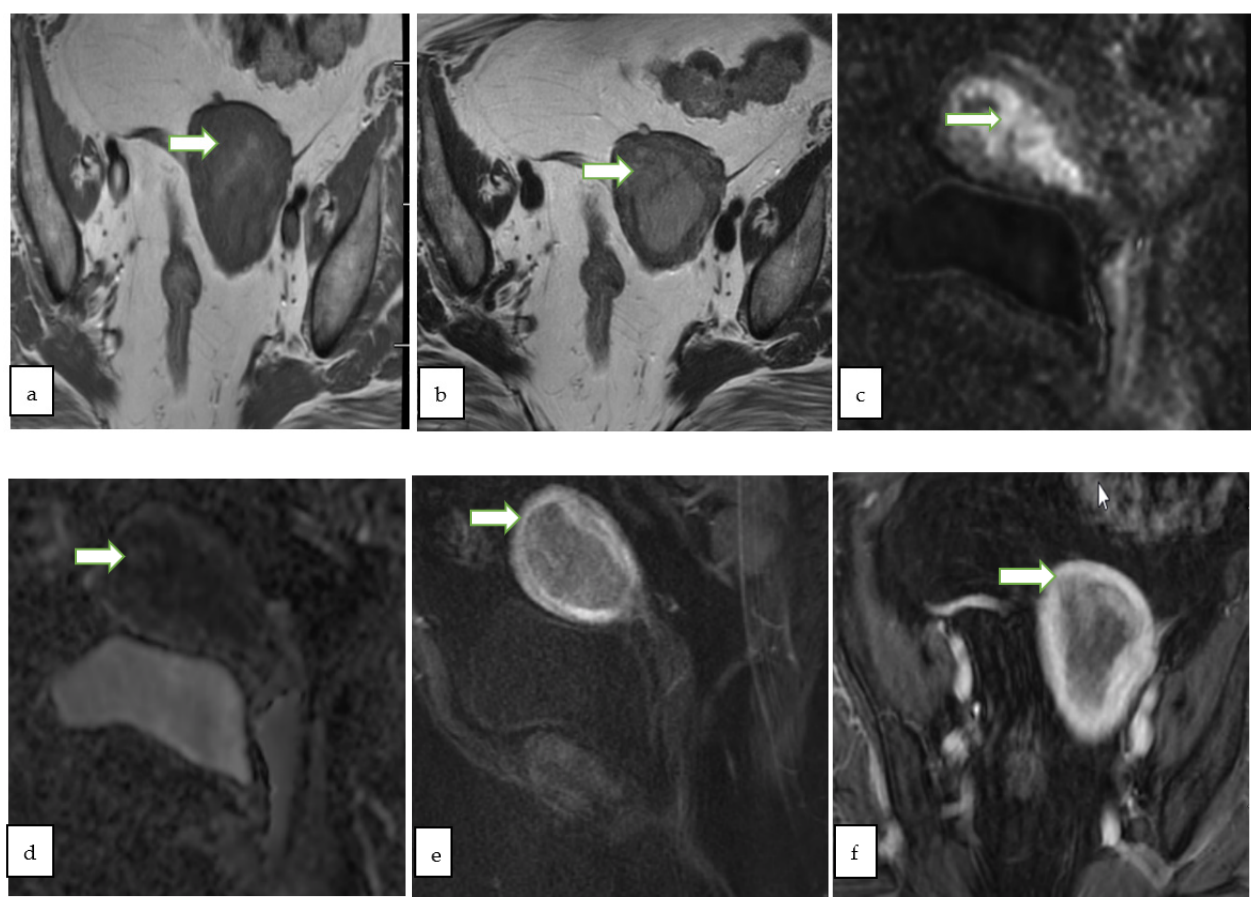
Figure 5. Axial T1W ( a ), axial T2W ( b ) MR images through the pelvis of a 59 year old lady with post menopausal vaginal bleeding show a predominantly hypointense expansile endometrial mass. The mass shows diffusion restriction with bright signal onsagittal DWI ( c ) with corresponding low ADC value ( d ). On sagittal ( e ) and axial ( f ) post contrast fat saturated T1W images, the mass shows >50% thick myometrial invasion of the anterior uterine wall. The patient underwent total hysterectomy and pathology revealed endometrial endometrioid adenocarcinoma.